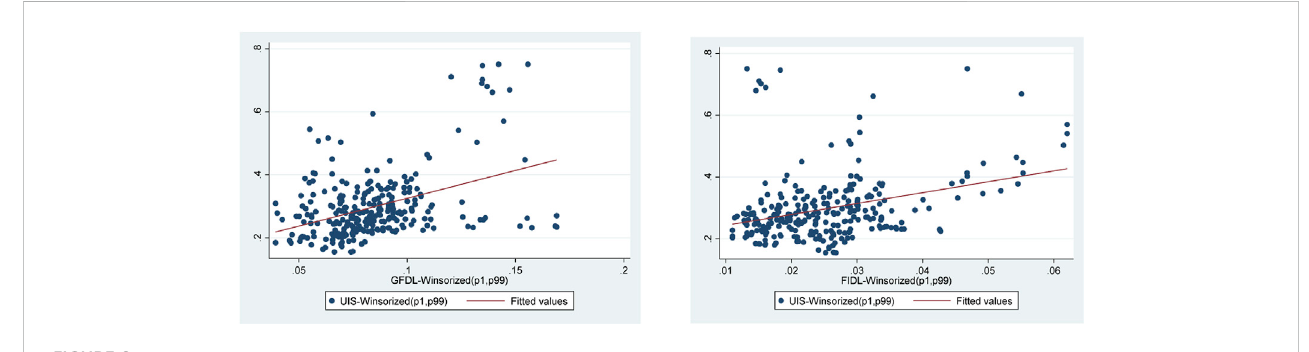
FIGURE 8 Fitted graph of green fi nance and industry